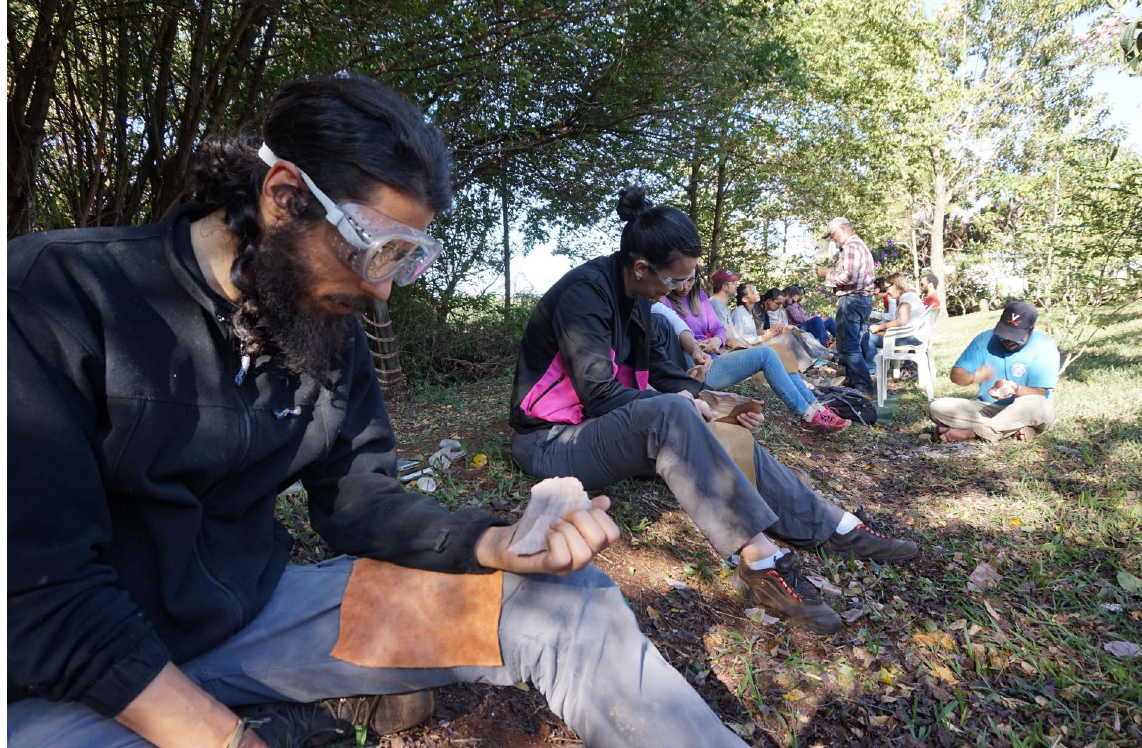
Figure 3. Participants of the workshop practicing unifacial and bifacial knapping. (Photograph by Nicolás Batalla,